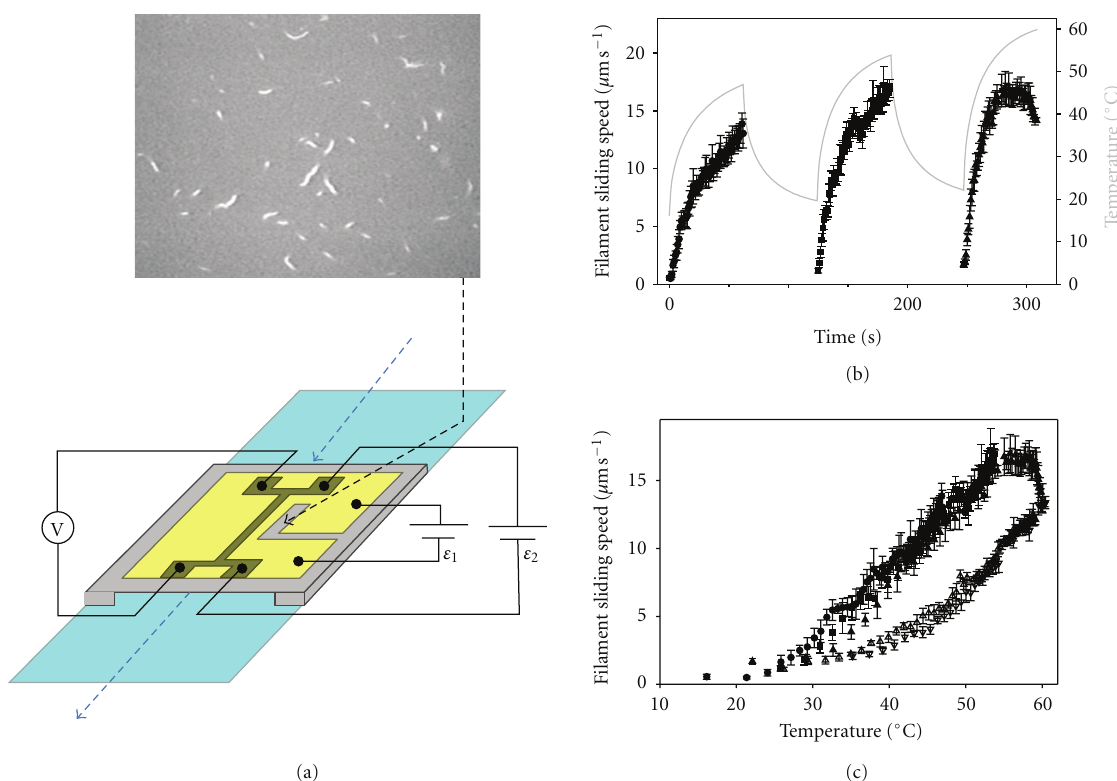
Figure 1: Temperature dependence of HMM-driven sliding of RhPh-labeled actin filaments determined using a microfabricated thermoelectric heater. (a) Modified flow cells were constructed as described [5]. Flow cells consisted of a microscope slide (light blue) and a modified cover slip (gray and gold), separated by two, thin spacers and held together by nonfluorescent vacuum grease. Solutions (Section 2.2) are pipetted through the flow cell as indicated by the blue, dashed arrows. To warm the flow cell, current is injected via circuit ε 1 into a microfabricated thermoelectric heater (gold) on the coverslip’s outer surface; flow cells are cooled by circulating chilled water through a copper coil wrapped around the microscope objective. Temperature is monitored via a linear, resistive thermometer (dark gold structure) that was microfabricated on the inner face of the coverslip (i.e., on the same side where actomyosin motility occurred, and opposite to the side with the thermoelectric heater); temperature is obtained from a calibrated voltage readout (V) with bias current set by circuit ε 2 . Motion of fluorescently labeled filaments on the inner side of the coverslip (top micrograph) is observed and recorded through a window (black, dashed arrow) located immediately adjacent to the thermometer. (b) Time course of temperature (gray line; right ordinate) and sliding speed (solid symbols; left ordinate) for regulated thin filaments (F-actin plus native cTn and α -Tm) at pCa 5 during the heating phase of three cycles of heating and cooling (Section 2). Points represent mean ± S.D. of the sliding speed for 3–8 filaments during 1 s. Note that the upper limit of the temperature-dependent increase in sliding speed occurs at ∼ 54 ◦ C ( t > 4 . 5 min). (c) The data from (b) were replotted to eliminate time: cycle 1 ( (cid:2) ), cycle 2 ( (cid:2) ), and cycle 3 ( (cid:3) ). An additional dataset for unregulated F-actin sliding is shown: cycle 1 ( (cid:5) )